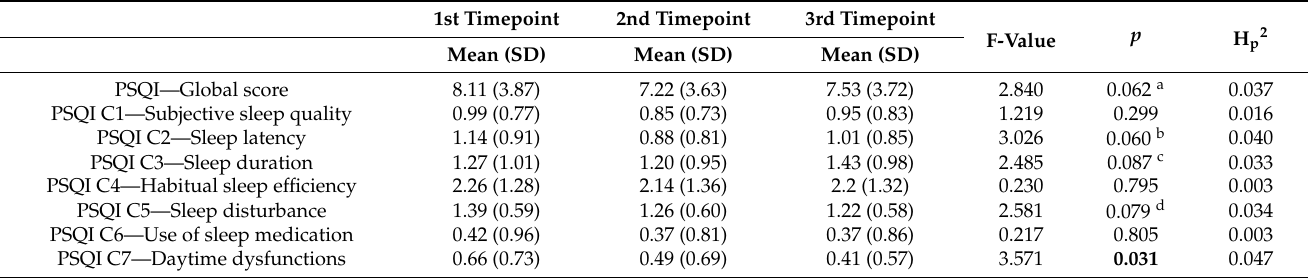
Table 2. Changes in the PSQI components over the three time points.